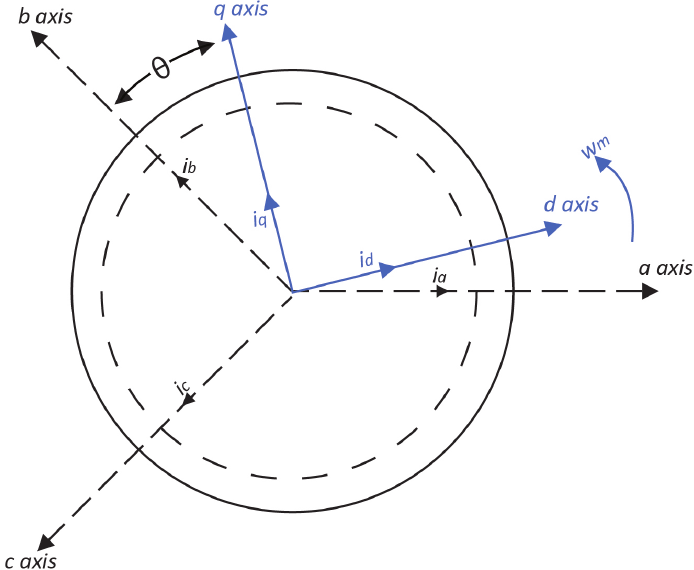
Figure 2. IPMSM cross sectional in abc and dq